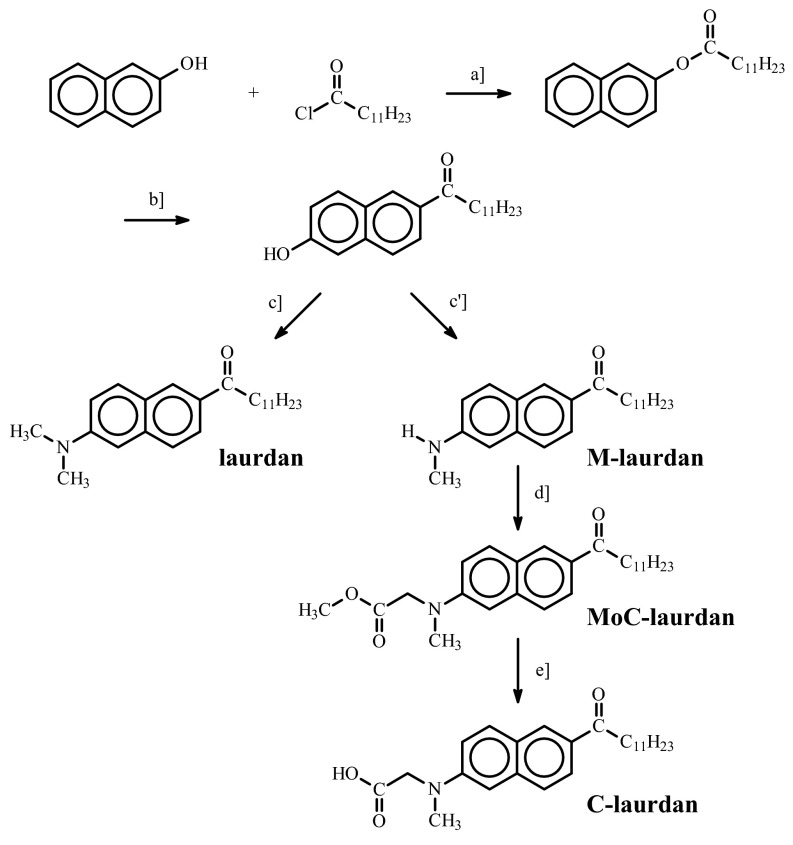
Synthesis pathway of laurdan, M-laurdan, MoC-laurdan and C-laurdan.Reagents and conditions:
a] Naphthol-2, Lauroyl chloride (triethanolamine);
b] Fries rearrangement, Methane sulfonic acid;
c] (CH
3)2NH HCl, Na
2S
2O
5, NaOH, H
2O;
c'] CH
3NH
2 HCl, Na
2S
2O
5, NaOH, H
2O;
d] BrCH
2COOCH
3, Na
2HPO
4, CH
3CN;
e] KOH, EtOH.